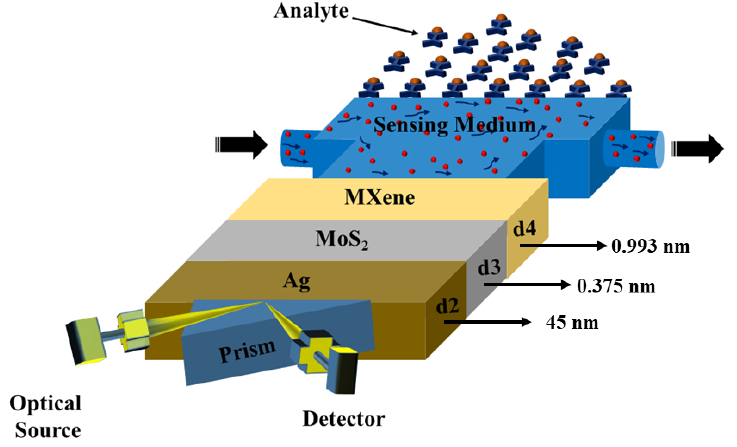
Figure 1. Sensor diagram.